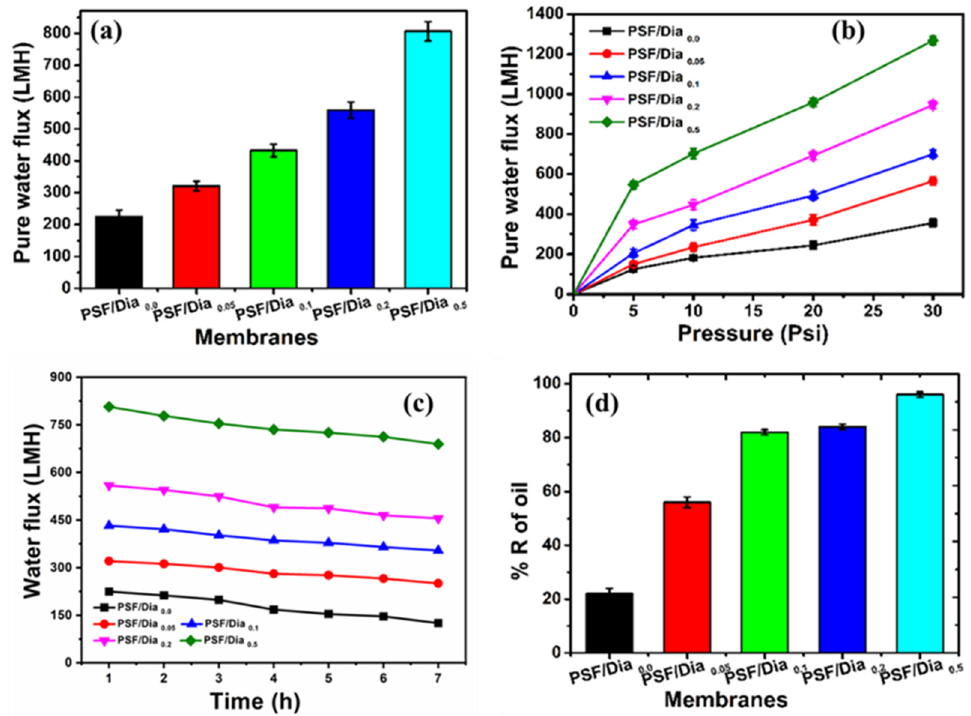
Figure 11. Performance of the membranes: ( a ) pure water flux, ( b ) pure water flux at different operating pressures, ( c ) fouling study, and ( d ) motor oil rejection.